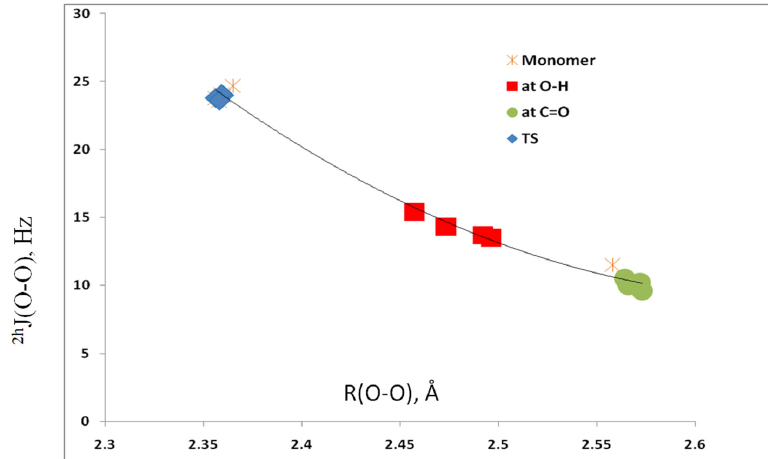
Figure 6. 2h J(O–O) versus the O–O distance for complexes 1 :acid.